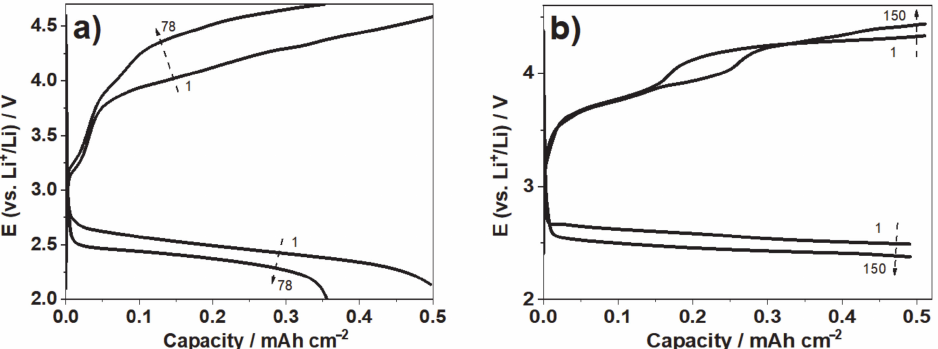
Figure 8. Li-O 2 discharge-discharge profiles of 1 M LiTFSI in Triglyme electrolyte in oxygenated cell using AEG as a cathode, ( a ) without and ( b ) with 5 mM Ru(bpy) 3 (ClO 4 ) 2 . Current density of 0.1 mA cm − 2 . Discharge limited to 0.5 mAh cm − 2 . The cycle number is indicated inside.